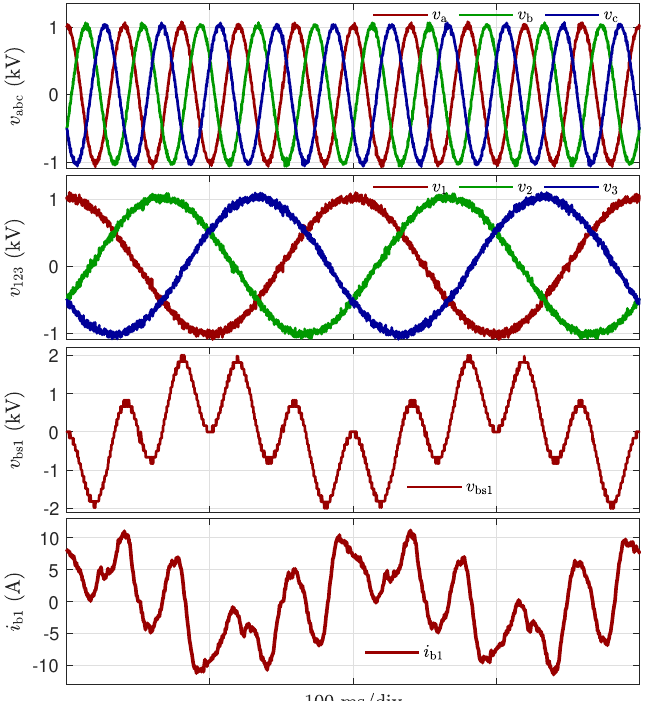
Figure 13. PD–SPWM: AC three–phase voltages v abc , v 123 , branch voltage v bs1 , and branch current i b1 .